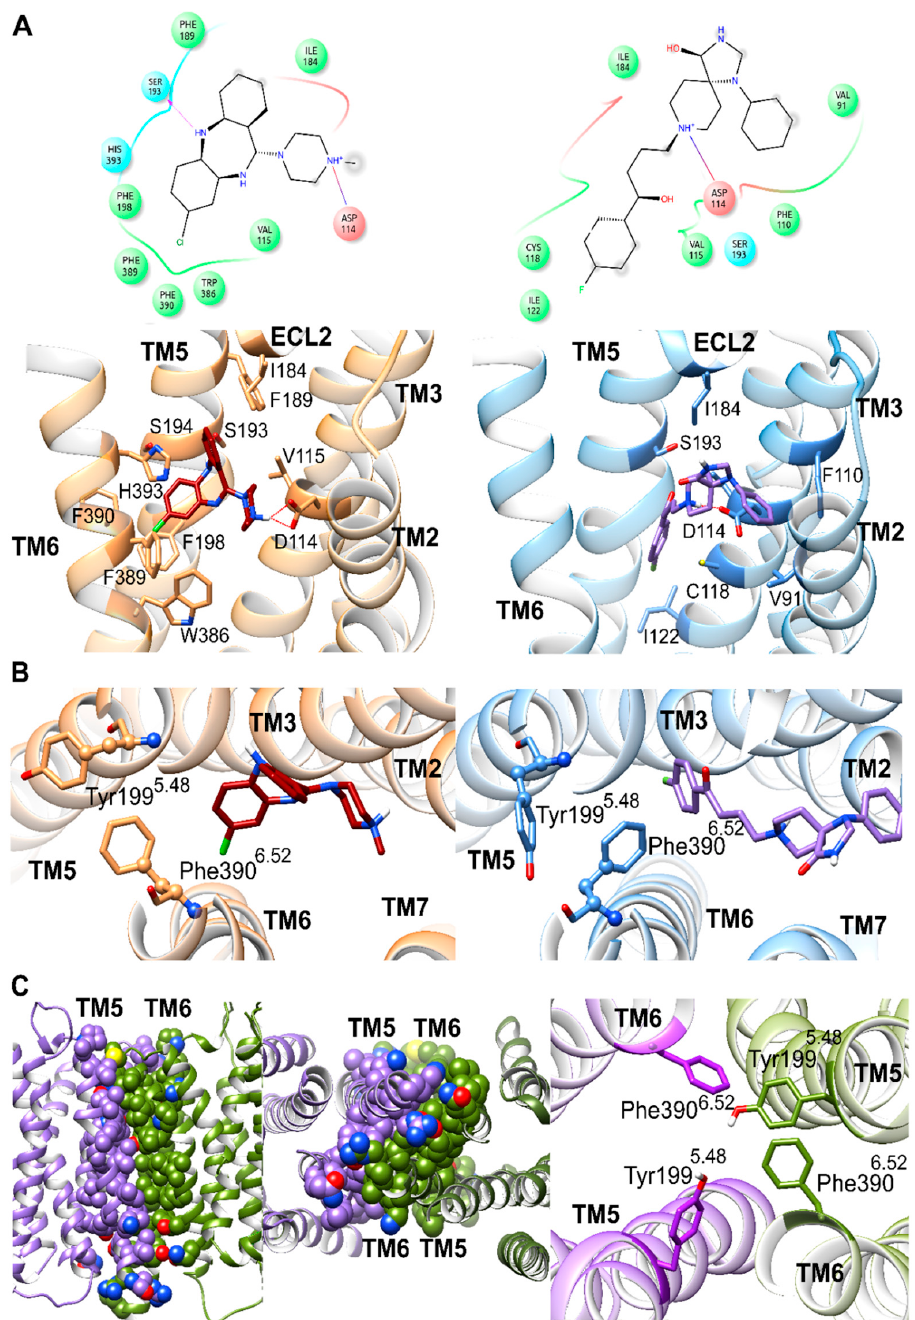
Figure 4. D 2 R monomer and homodimer complexes. Transmembrane helices are labeled as TM. ( A ) 2D and 3D (top and bottom, respectively) stable binding poses of residues (abbreviated following three letter or single letter code, respectively) in close contact during molecular dynamics (MD) simulation (<3.5 Å) with clozapine and spiperone (dark red and purple, respectively) bound to respective D 2 R monomer (left and right, colored in orange and blue, respectively). ( B ) Trans and cis conformations of Tyr199 5.48 and Phe390 6.52 χ 1 dihedral angles selected by bound clozapine or spiperone (dark red and purple respectively) bound to D 2 R monomer (left and right, colored in orange and blue, respectively). ( C ) From left to right, lateral and intracellular views of TM5–TM6–TM5–TM6 D 2 R homodimer model interface, which generates aromatic interactions between Tyr199 5.48 and Phe390 6.52 of both D 2 R protomers during MD simulation (colored in purple or green, respectively).